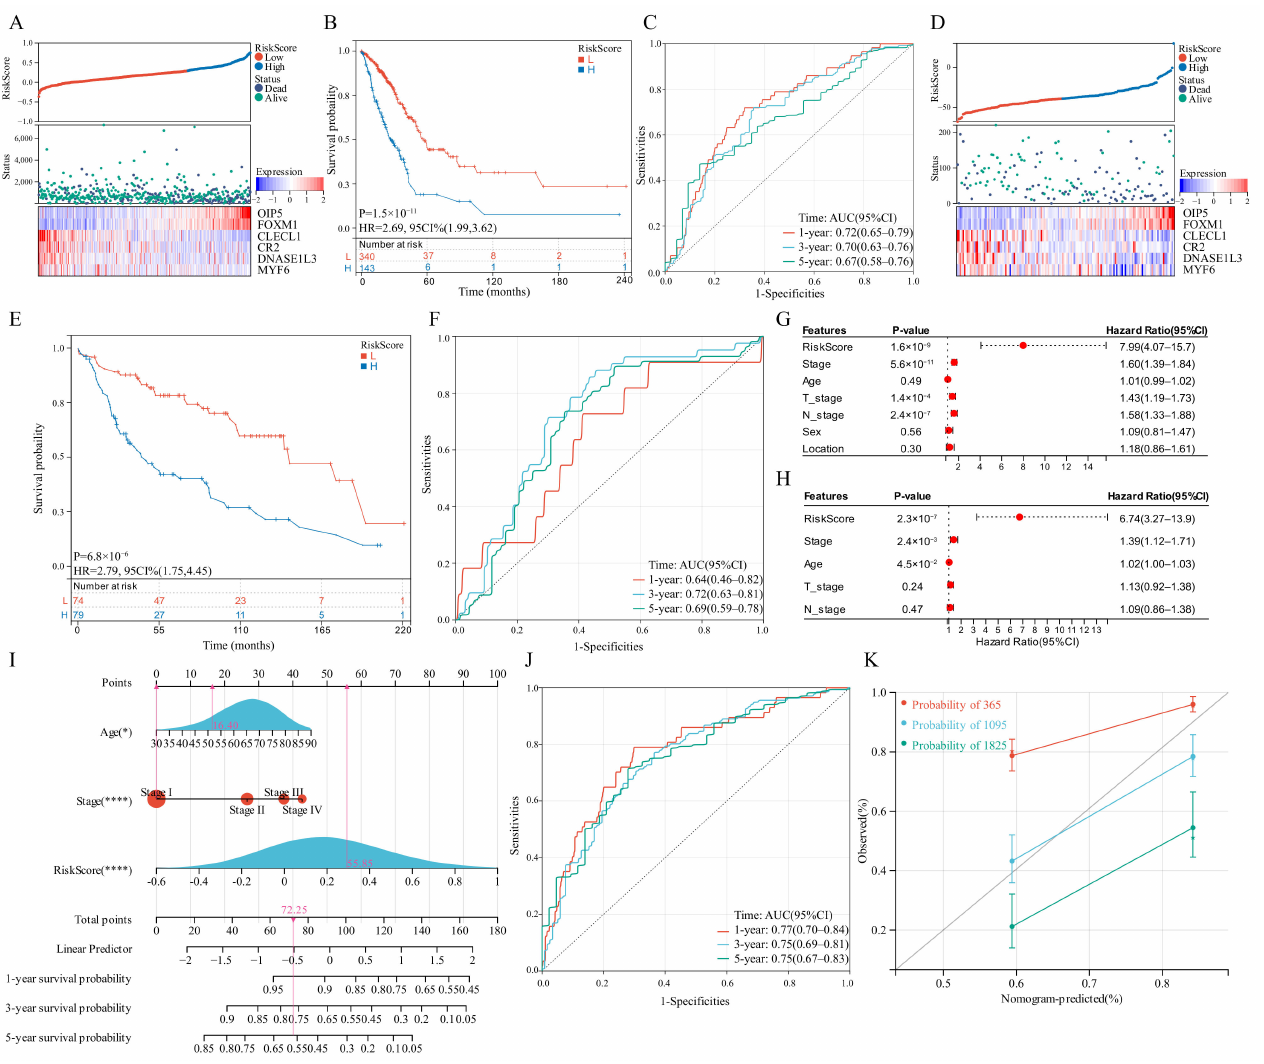
Figure 6. Survival analysis of the risk score model and integrated nomogram. ( A , D ) Risk scores split line, survival status of individual and heatmap of the six GSTTK in the TCGA or GEO cohorts. ( B , E ) Kaplan-Meier analysis exhibits the prognostic significance of the risk score in TCGA or GEO cohorts. ( C , F ) Time-dependent receiver operating characteristic (ROC) analysis demonstrates the specificity and sensitivity of the risk score in TCGA or GEO cohorts. ( G , H ) Univariate and mul- tivariate Cox analyses of TCGA-LUAD cohort. ( I ) Integrated nomogram including risk score and important clinical features. ( J ) ROC analysis of the integrated nomogram. ( K ) Calibration curve of the integrated nomogram at 1, 3 and 5 years in TCGA-LUAD